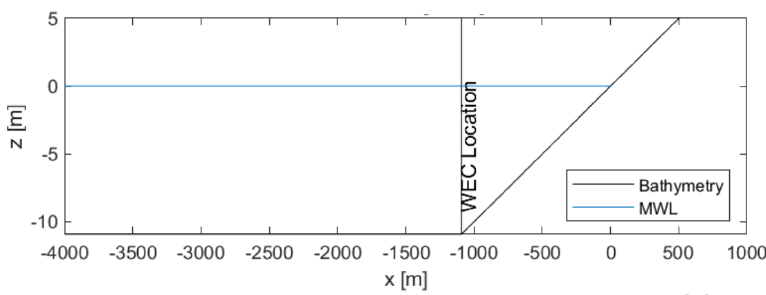
Figure 3. Cross–section of the 3D bathymetry used in XBeach for all